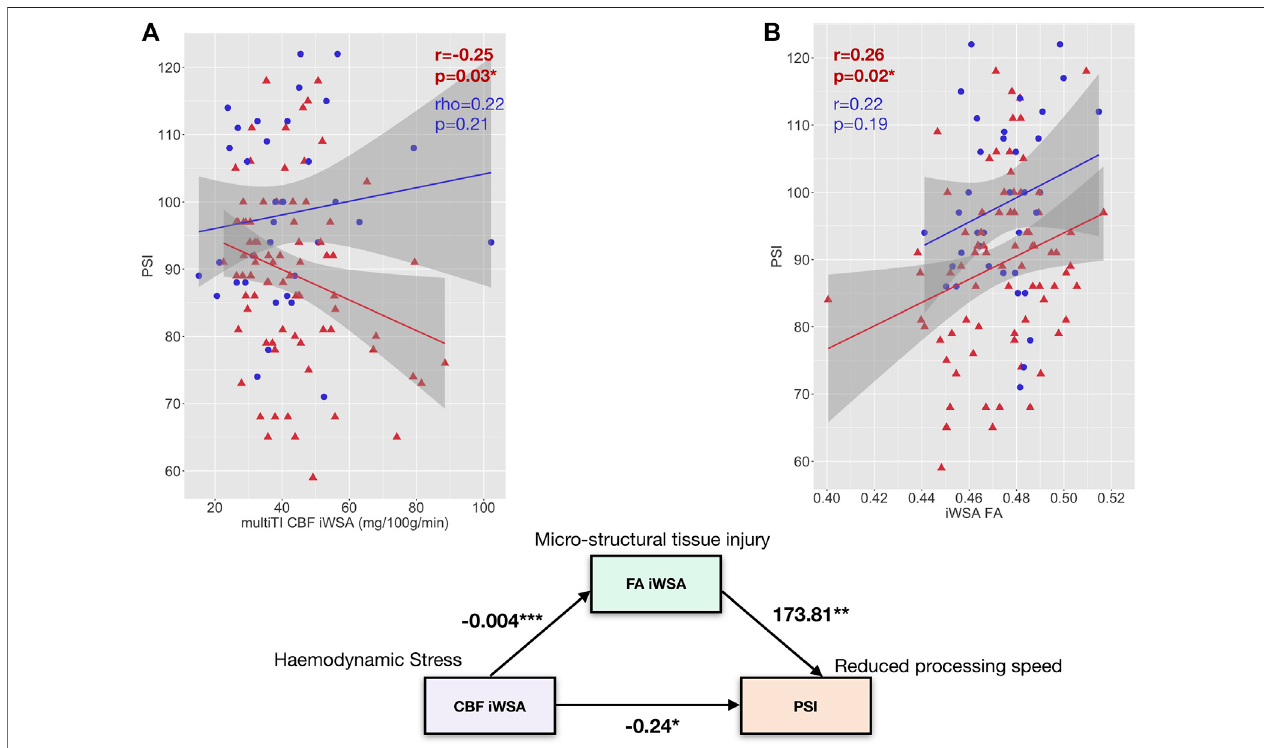
FIGURE 8 | Exploratory Mediation Analysis. (A) Scatterplots showing the relationship between PSI and age- and sex-adjusted mean cerebral blood fl ow (CBF) across individual watershed areas (iWSA) based on the multi-in fl ow time sequence (left) and fractional anisotropy across iWSA in patients with sickle cell anemia (shown in red) and controls (shown in blue). (B) : A path diagram showing the direct effect of mean cerebral blood fl ow (CBF) across white matter with late arrival times/individual watershed areas (iWSAs) on processing speed index (PSI) alongwith the indirect effectof CBF on PSIthrough fractional anisotropy across this region (FA iWSA) in SCD patients. Values are unstandardized regression coef fi cients. * p < 0.05, ** p < 0.01, *** p <